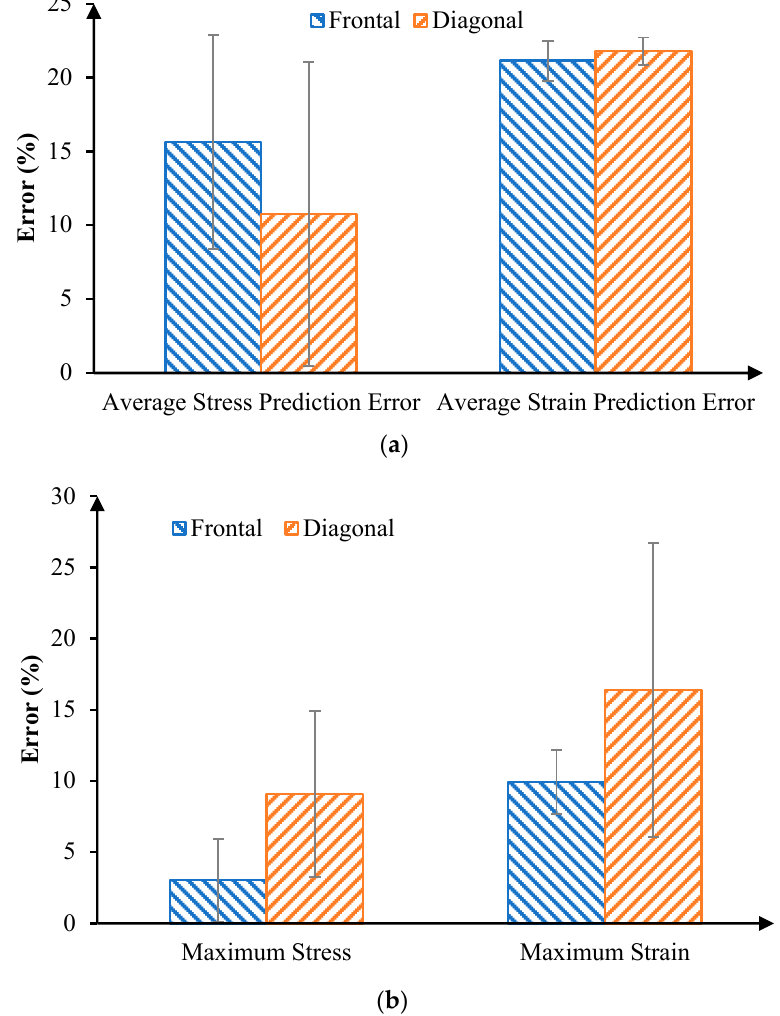
Figure 8. ( a ) Comparison of average stress and strain error between FE results and PLSR prediction results. ( b ) Comparison of maximum stress and strain predicted error.